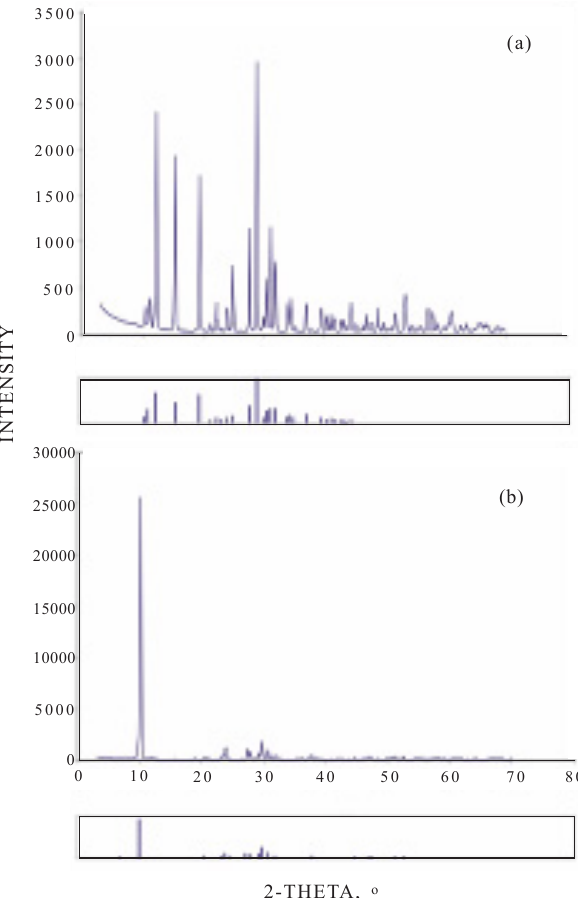
Figure 1. X ray diffractogram and powder diffraction file (PDF) data of the compounds H8-syn (A) and H14-syn (B).